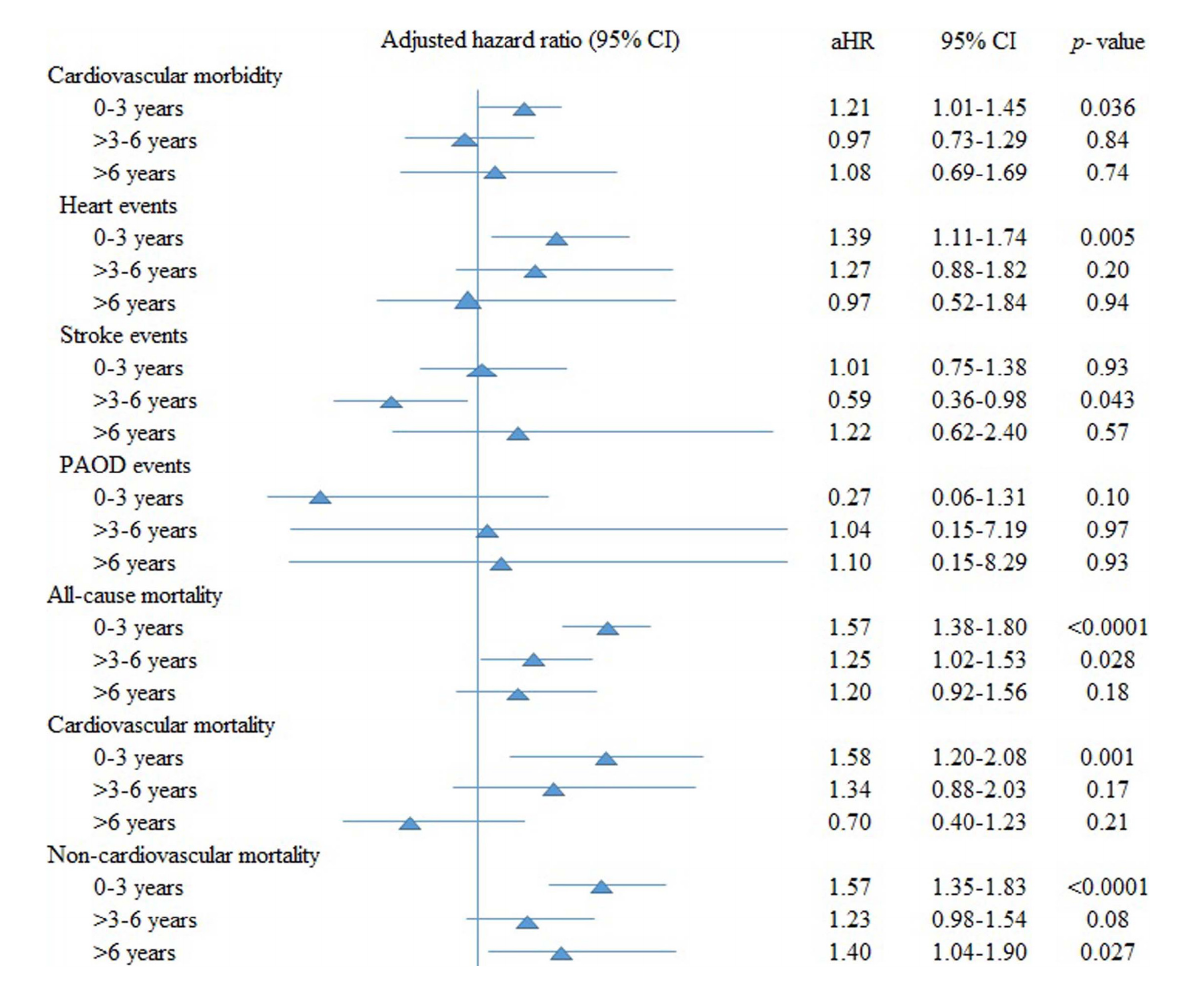
FIGURE2 The adjusted hazard ratios (aHRs) of all outcomes stratified by follow-up periods of clarithromycin use compared with non-use. CI, confidence interval; PAOD, peripheral arterial occlusion